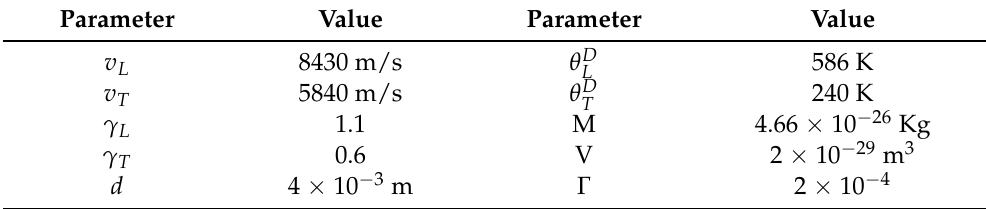
Table 1. Physical parameters for Si.